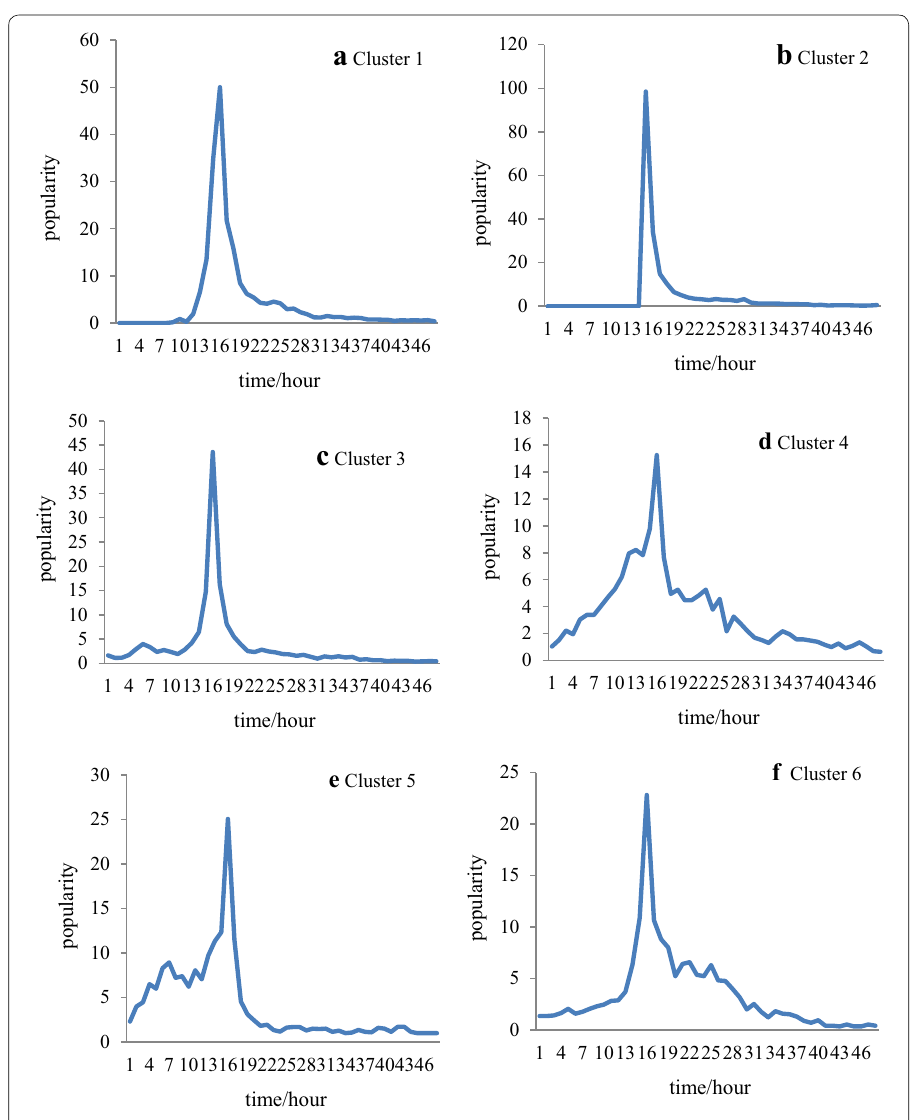
Fig. 3 Clusters identified by K-SC clustering algorithm, K = 6 . This figure shows temporal patterns